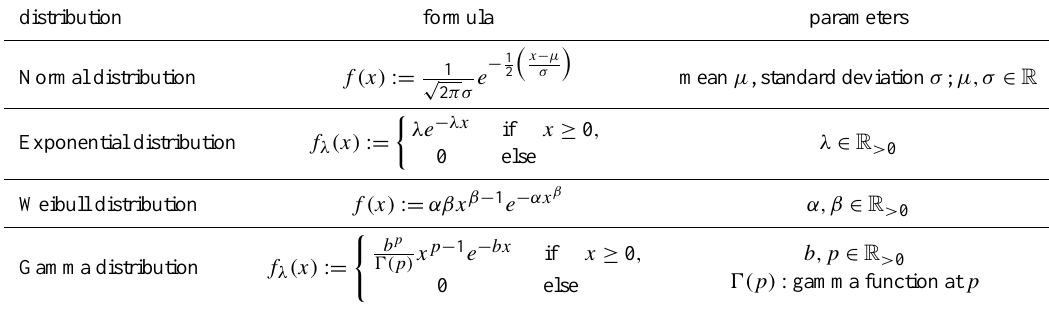
Table 2. Marginal distributions. distribution formula